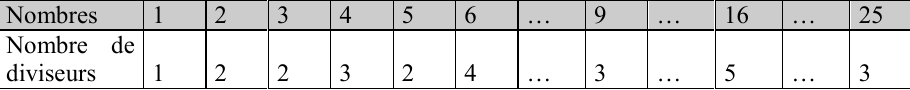
Tableau 1 : génération des nombres de